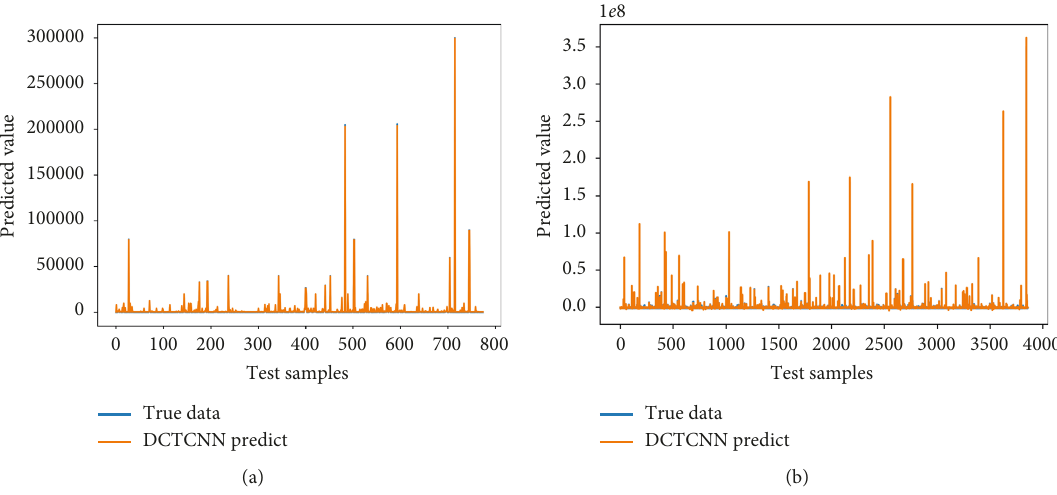
Figure 12: Testing performance of DCTCNN on (a) UCI seismic bumps and (b) AAIA ′ 16 seismic.